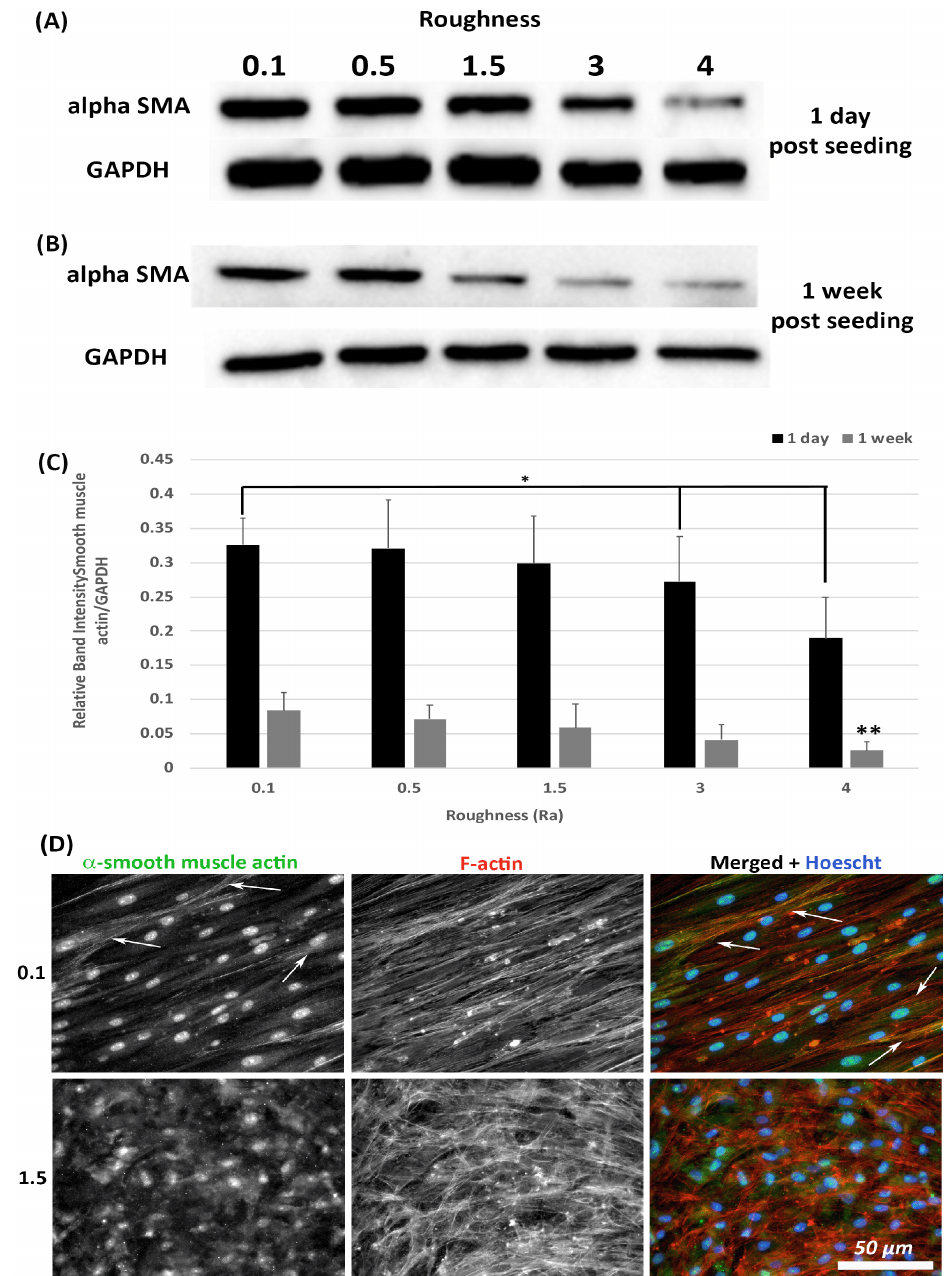
Figure 5. Expression of α -SMA in response to altered substratum roughness. HGFs were cultured on each topography and protein extracted at ( A ) 24-h and ( B ) 7-days post seeding to ( C ) quantify protein expression of α -SMA. At 24-h post seeding, surfaces with R a = 3.0 and 4.0 significantly reduced α -SMA expression (* = p < 0.05 vs cells grown on 0.1 at 1 day). At 7-days post seeding, only R a = 4.0 significantly reduced α -SMA protein expression compared to PT (** = p < 0.05 vs cells grown on 0.1 at 7 days). One-way ANOVA followed by a Bonferroni adjustment. All experiments were run in triplicate with cells isolated from 3 different individuals. ( D ) Cells were cultured on each topography for 7 days and labelled with antibodies specific to α -SMA and FITC phalloidin to visualize F-actin stress fiber networks. Representative images are shown from 0.1 and 1.5. Only HGFs cultured on R a = 0.1 exhibited high levels of α -SMA incorporation into stress fiber bundles (indicated by white arrows).